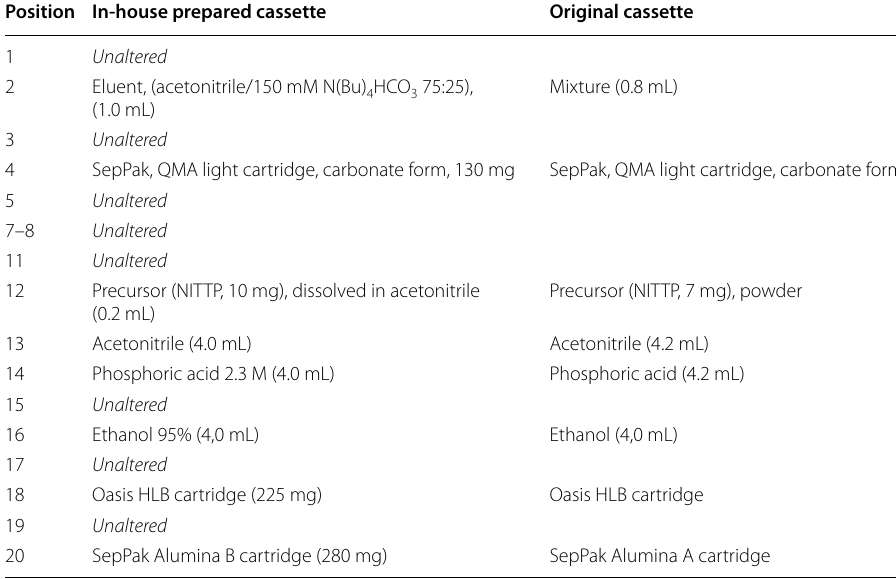
Table 2 Starting materials used in in-house prepared and original cassettes for [ 18 F]FMISO FASTlab